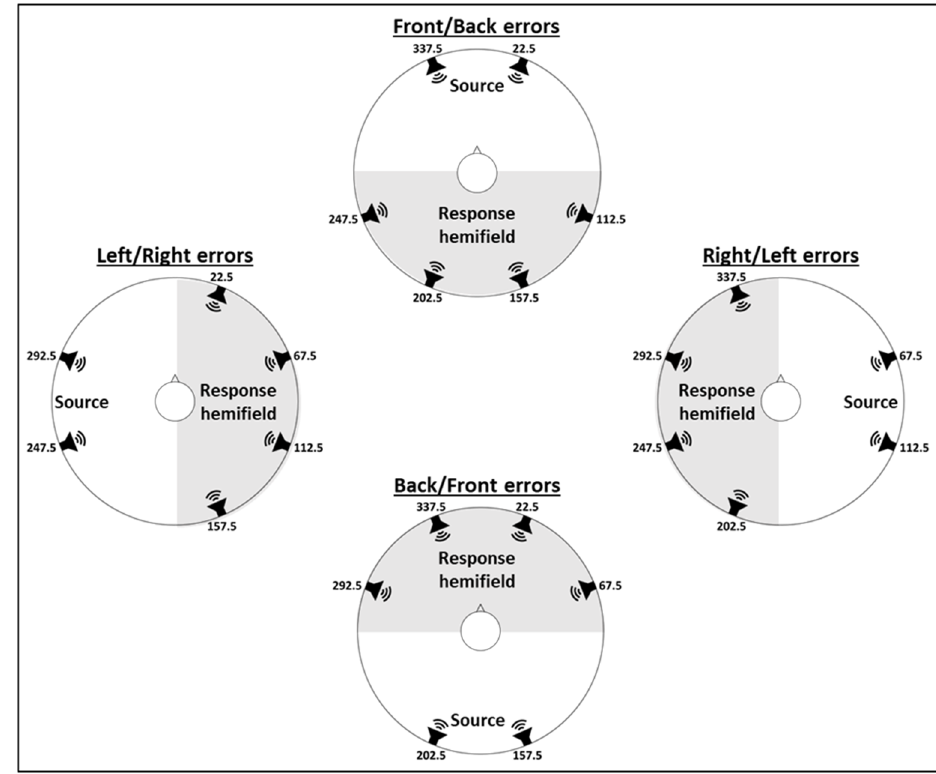
Figure 4. Mirror image reversal errors for each of the four hemifields. Errors were defined by a response opposite the hemifield of the source monitor, as indicated by the shaded areas in each hemifield.